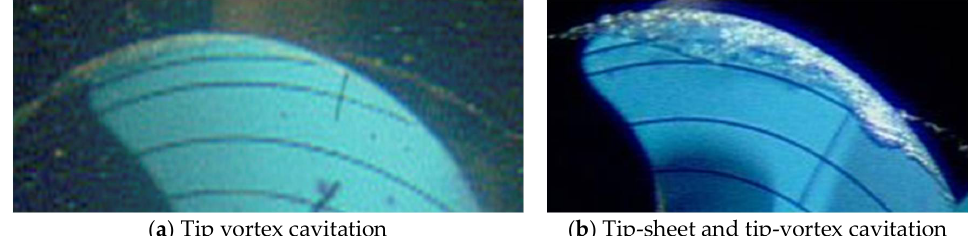
Figure 6. Examples of cavitation patterns on the propellers used for the development of the method.